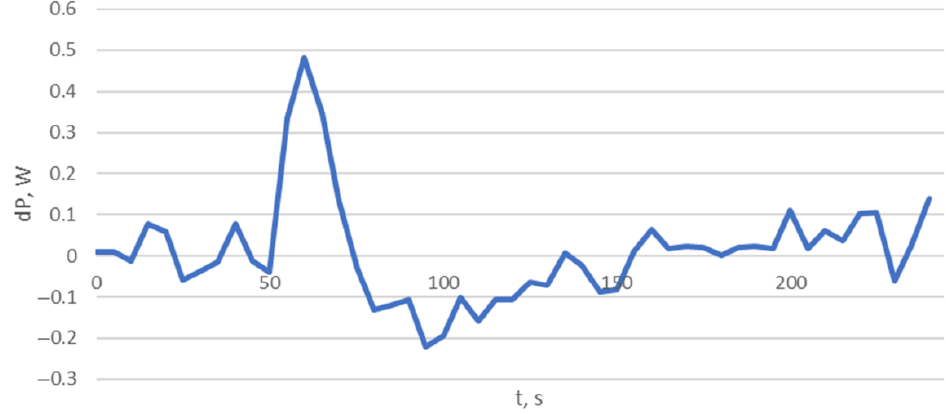
Figure 7. Residual power for T 0 Equation in (15) with coefficients from Table 4.